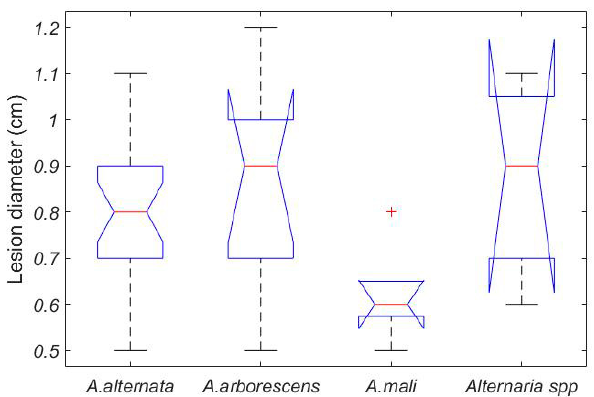
Figure 4. Boxplots (median (red), upper and lower 25 th and 75 th percentiles, 95% confidence intervals) of lesion diameters produced on inoculated Cakile maritima plants by different Alternaria spe- cies. The large overlap for A. alternata, A. arborescens, Alternaria spp. is